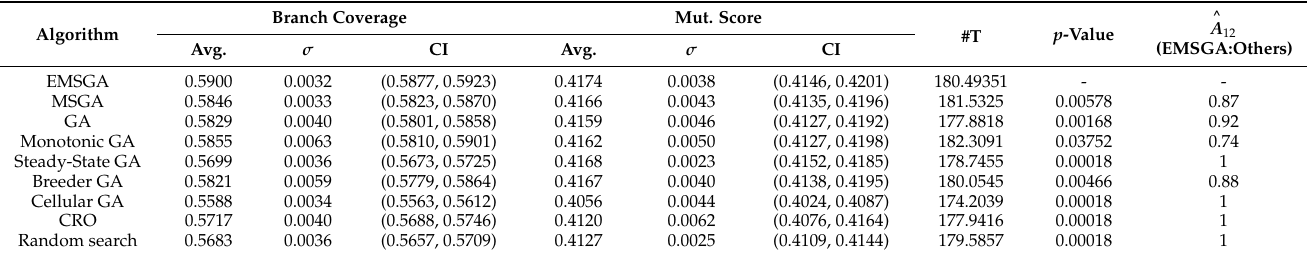
Table 4. Results of test case generation using each